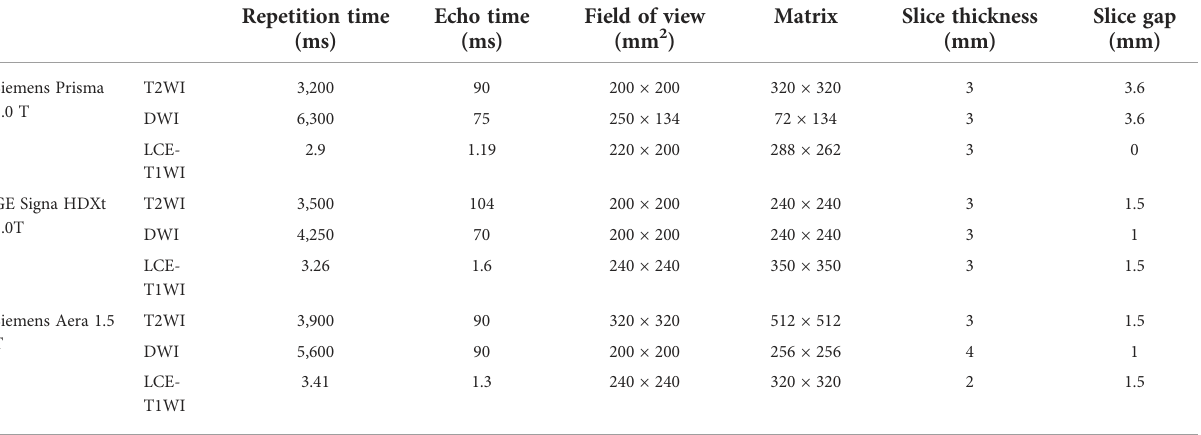
TABLE 1 The parameter details of primary